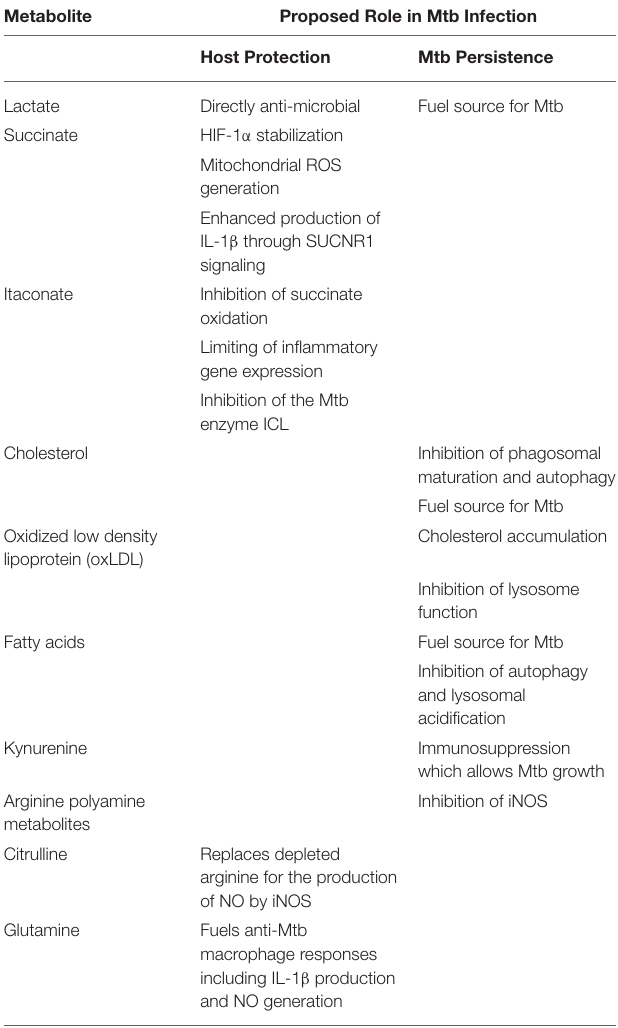
TABLE 1 | Metabolites implicated in Mtb